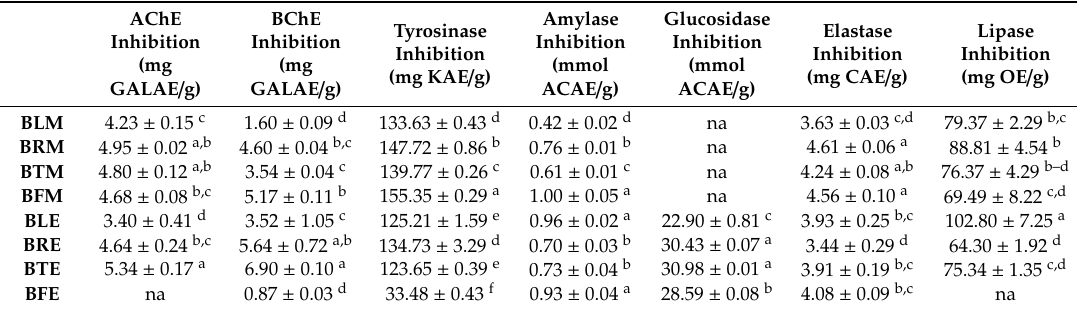
Table 7. Enzyme inhibitory e ff ects of B. gymnorhiza